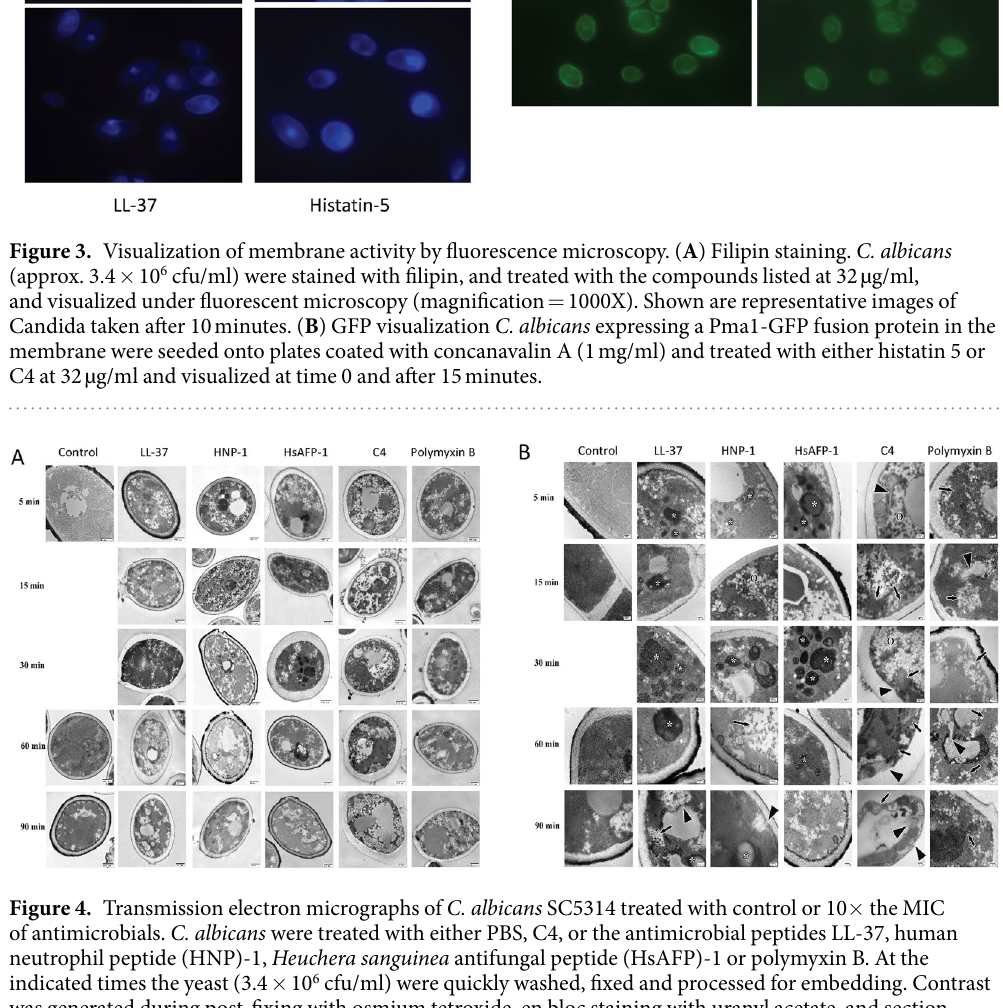
However, with respect to structural damage, the C4 treated series diverges from the antimicrobial peptide series by 30 minutes, and by 60 minutes the cellular deterioration in yeast treated with C4 resembles the polymyxin series, with organelle distortion (smaller arrows), membrane dissolution and internalization (large arrowheads) being observed. Candida treated with the peptides (LL-37, HNP-1, and HsAFP-1) appear to continue with a similar processes that are distinct from that seen with C4. The yeast treated with C4 and polymyxin for 60 and 90 minutes have grossly distorted internal structures or lack them completely, although the effects of C4 appear to be less severe than polymyxin B treatment. Polymyxin B treatment, however, does show occasional pores being formed in the plasma membrane. We had initially demonstrated the in vivo effect of this compound in two mouse models of oral candidiasis 25 . To extend this analysis to systemic infections we first needed to demonstrate the in vitro activity against strains